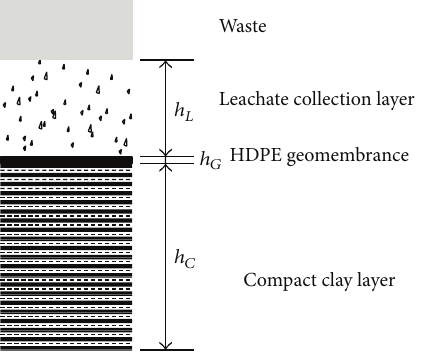
Figure 1: Schematics of the bottom liner system for MSW.